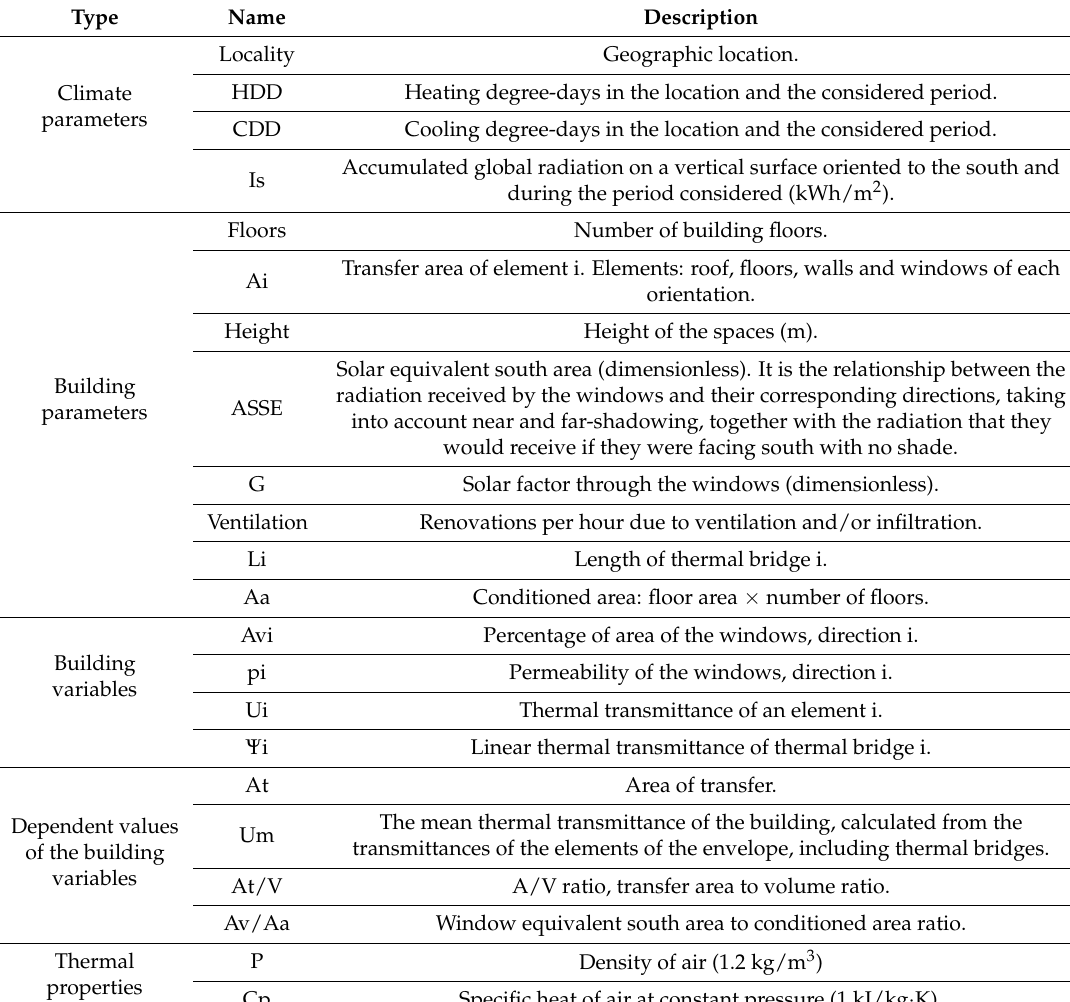
Table 1. Parameters, variables and data depending on